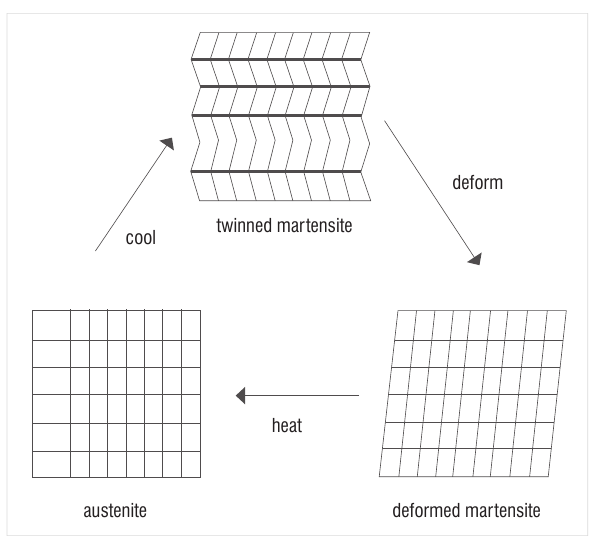
Figure 3: Microscopic illustration of the shape-memory effect.